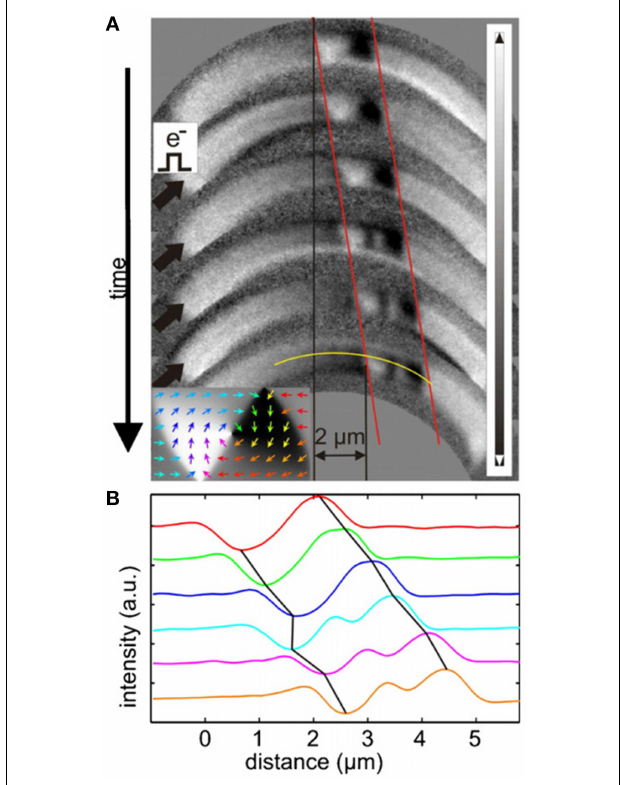
FIGURE 11 | From Heyne et al. [108] (A) Photoemission electron microscopy image series of a Py wire (1000nm wide, 40nm thick with a 2 nm Au capping) containing a vortex DW. The top image shows the configuration after the initialization by a short vertical field pulse. The inset in the lower left shows a micromagnetic simulation of a VW to help visualize the DW structure. The XPEEM images were taken with vertical contrast (see grayscale bar at the right) and the simulation was adapted to this contrast. Current pulses were injected between adjacent images (from top to bottom). After five injections the DW is displaced by 2 Î¼m, thus about 400 nm on average per current pulse. After the third pulse DW transformed to a double vortex that continues moving. (B) Intensity line scans along the yellow curve indicated by the yellow line in (A)